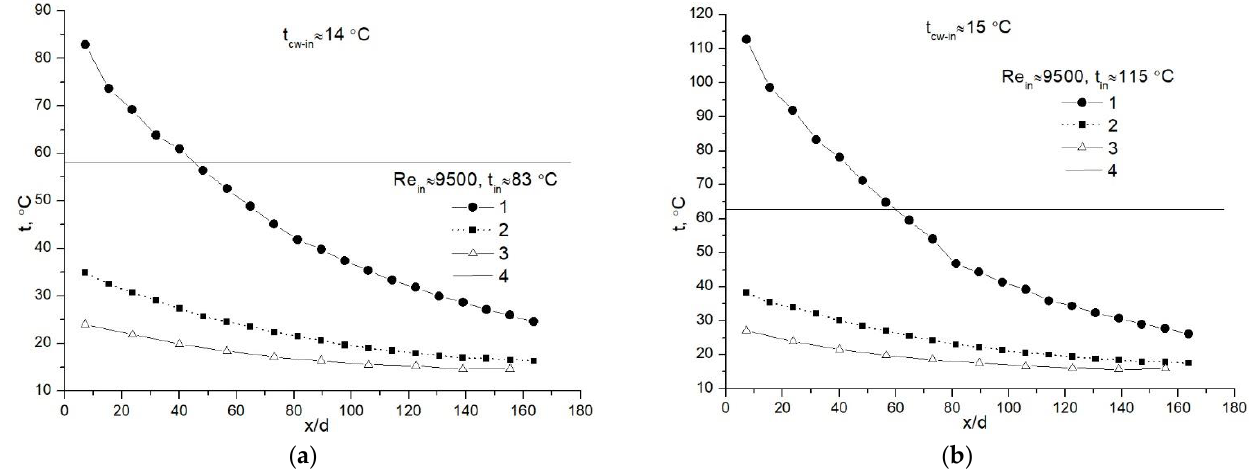
Figure 8. Temperature distribution in the heat exchanger at Re in ≈ 9500, at flue gas temperatures ( a ) t in ≈ 83 °C, ( b ) t in ≈ 115 °C, and at similar cooling water inlet temperatures: (1) center of the tube, (2) the inner wall of the tube, (3) cooling water, (4) the dew point temperature.